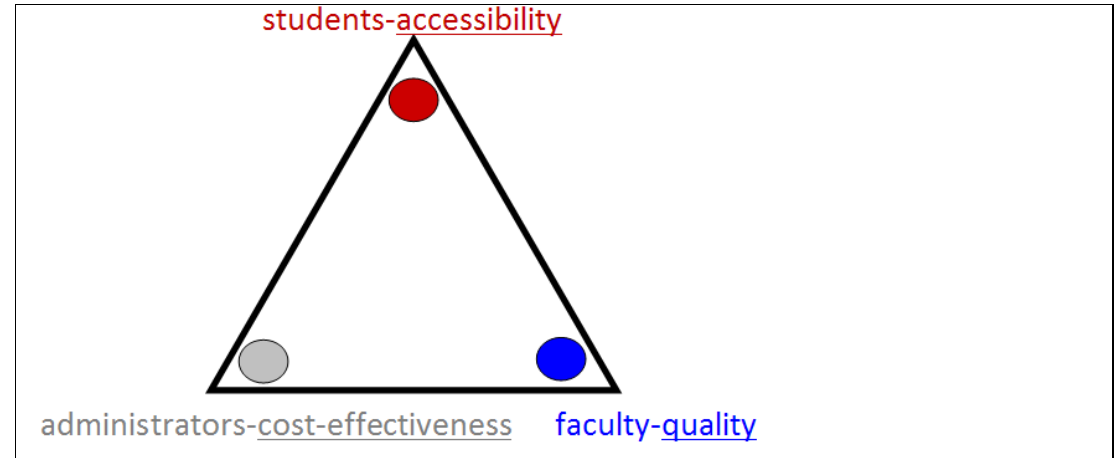
Figure 2 . The Power-Gould revised iron triangle associating stakeholders and stakeholder